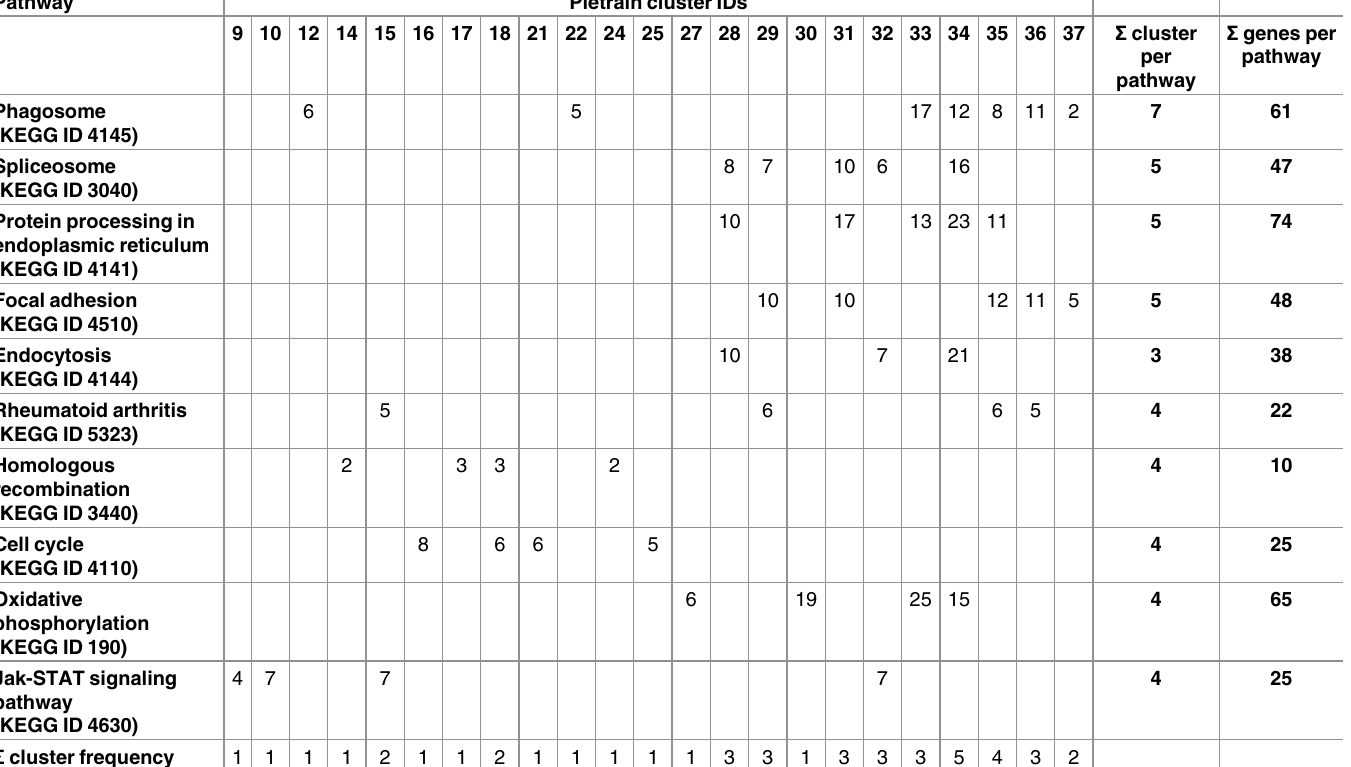
Table 1. Top 10 scored pathways using KEGG and clusteredRNA-Seq dataset post PRRSV infection, representedby the cluster ID of Pietrain lung DCs.